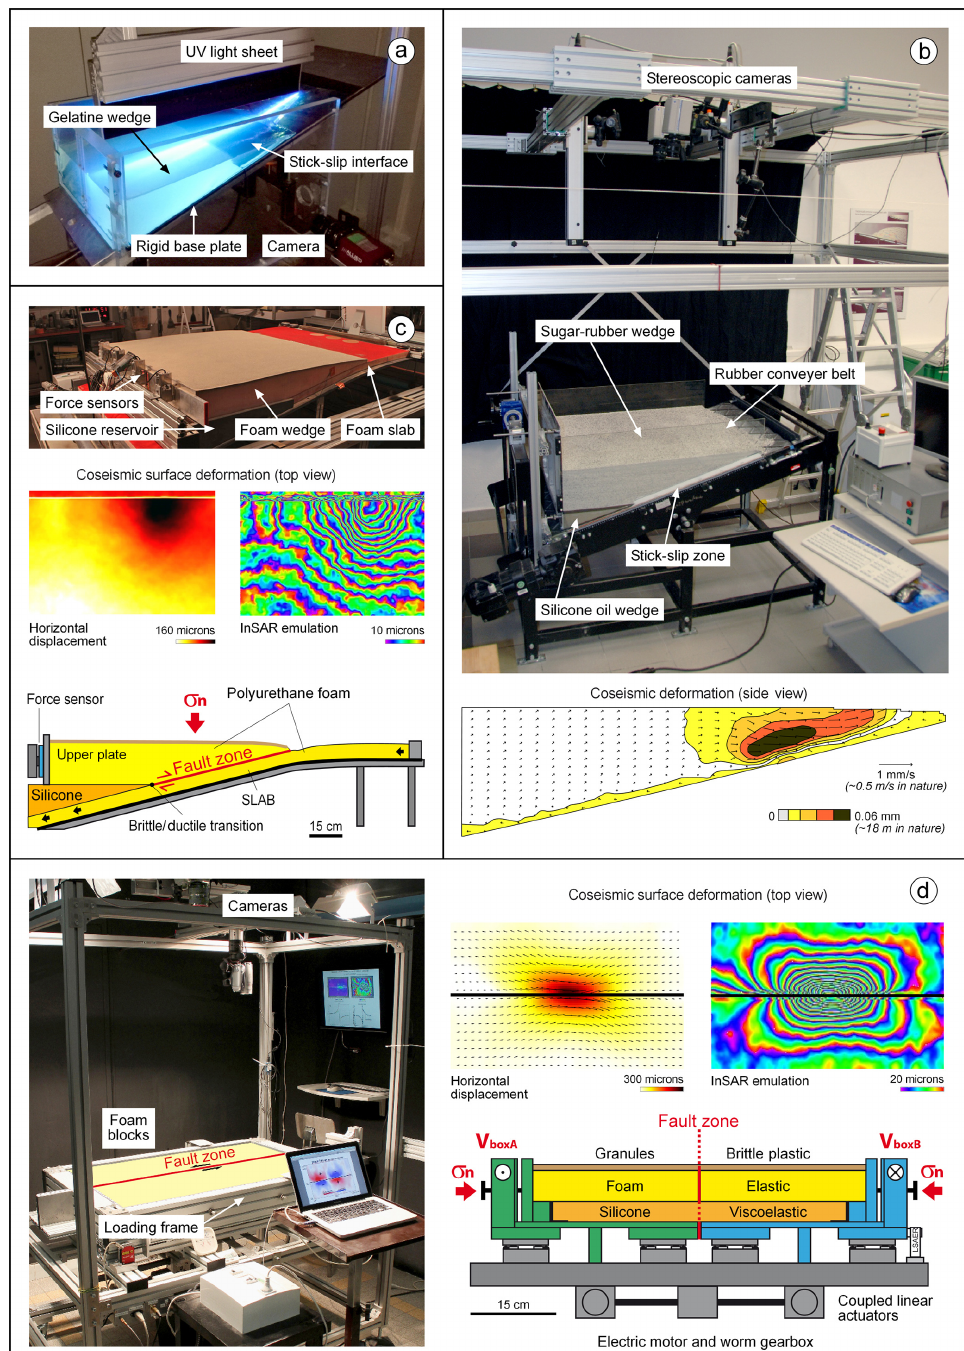
Figure 4. Examples of seismotectonic scale models: (a) viscoelastic gelatine wedge set-up used by Corbi et al. (2013) to study subduction megathrust earthquakes (modified from there); (b) elastoplastic granular wedge set-up used in this study to simulate subduction megathrust seismotectonic evolution, which is developed from a similar set-up used by Rosenau et al. (2009, 2010), and the resulting earthquake deformation pattern (side view, modified after Rosenau et al., 2009); (c) layered elastic–viscoelastic foam rubber–silicone wedge set-up used by Dominguez et al. (2015) to study subduction megathrust earthquakes and the resulting earthquake deformation pattern (top view; left: displacement; right: pseudo-InSAR fringe pattern); (d) layered elastic–viscoelastic foam rubber–silicone strike-slip set-up used by Caniven et al. (2015) and the resulting earthquake deformation pattern (top view; left: displacement; right: pseudo-InSAR fringe pattern) (modified from Caniven et al.,